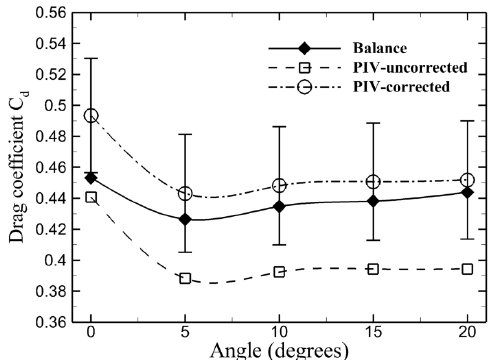
Figure 8. Drag coefficient at different angles of rotation of the front